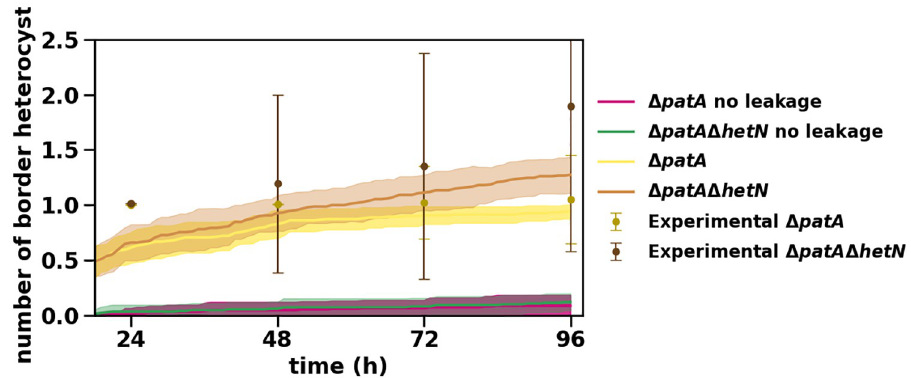
Fig 7. Temporal evolution of the number of heterocysts in the Δ patA and Δ patA Δ hetN mutants. Symbols represent experimental values from [12] and lines are simulation results with their standard deviation as a shadowed area.